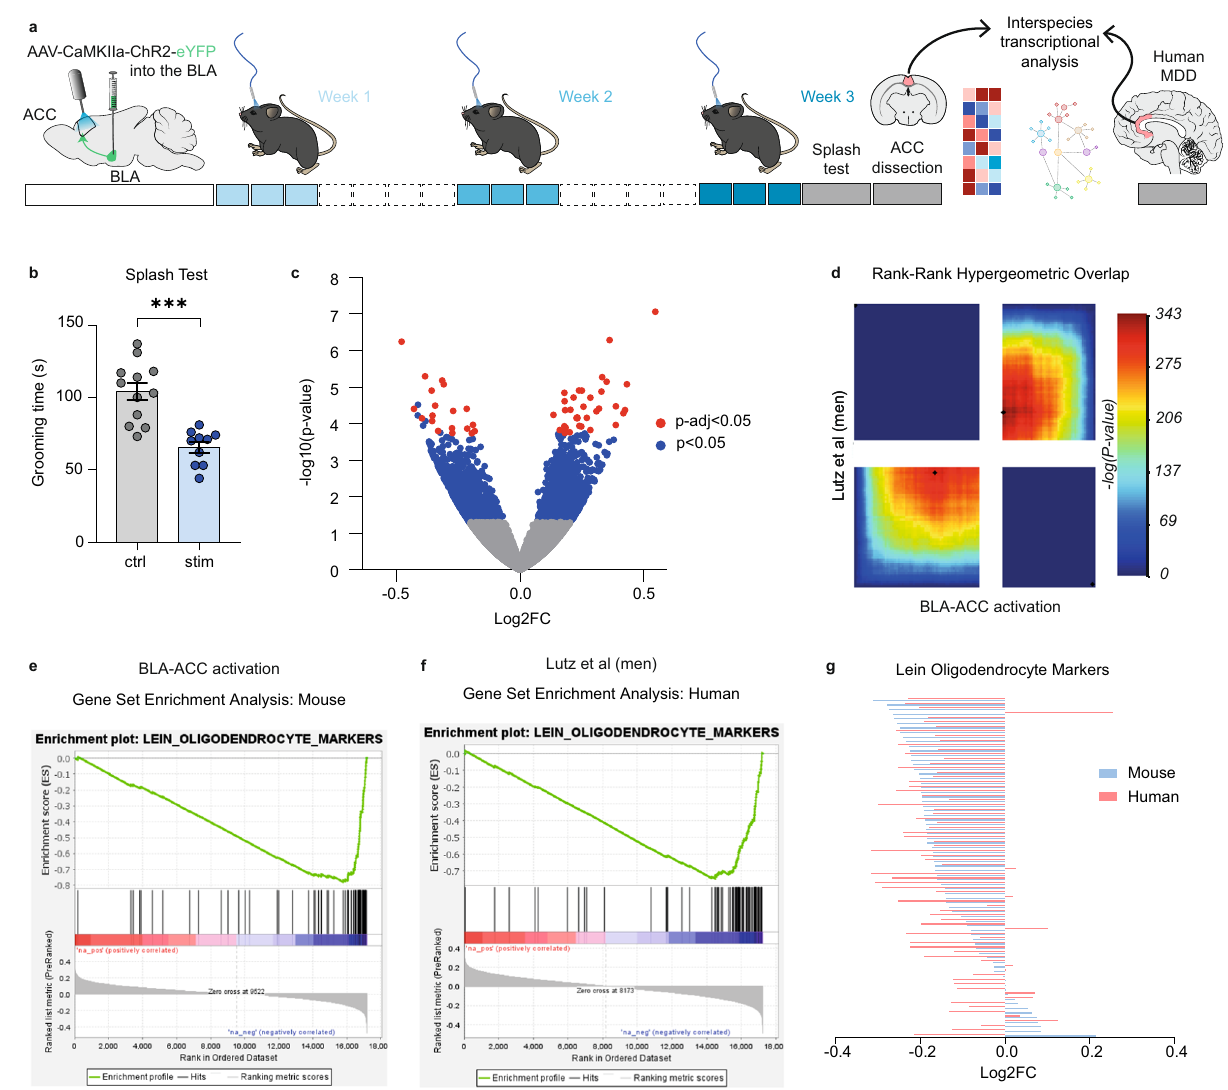
Fig. 5 | Repeated activation of the BLA – ACC pathway induces transcriptional alterationssimilartothoseobservedinhuman-depressedpatients.a Graphical representation of experimental design, including virus delivery into the BLA, can- nula implantation into the ACC, 9 sessions of optogenetic activation, ACC extrac- tion in mice, and transcriptomic analysis in mice and humans. b Nine sessions of optogenetic activation of the BLA – ACC pathwaydecreasedgrooming behaviors in stimulated animals used for RNA Sequencing (ctrl: n =12 mice; 104.2±6.0; stim: n =10 mice; 65.60±3.80; P <0.0001). c Volcano plot showing the 2611 (blue dot, 6.9%ofallgenes)genesdifferentiallyexpressed(nominal P values<0.05;Waldtest) between stimulated ( n =10) and control animals ( n =12). Red circles depict the 54 genes that showed a signi fi cant dysregulation after multiple testing correction ( P adj<0.05, Benjamini and Hochberg correction). d Rank-Rank Hypergeometric